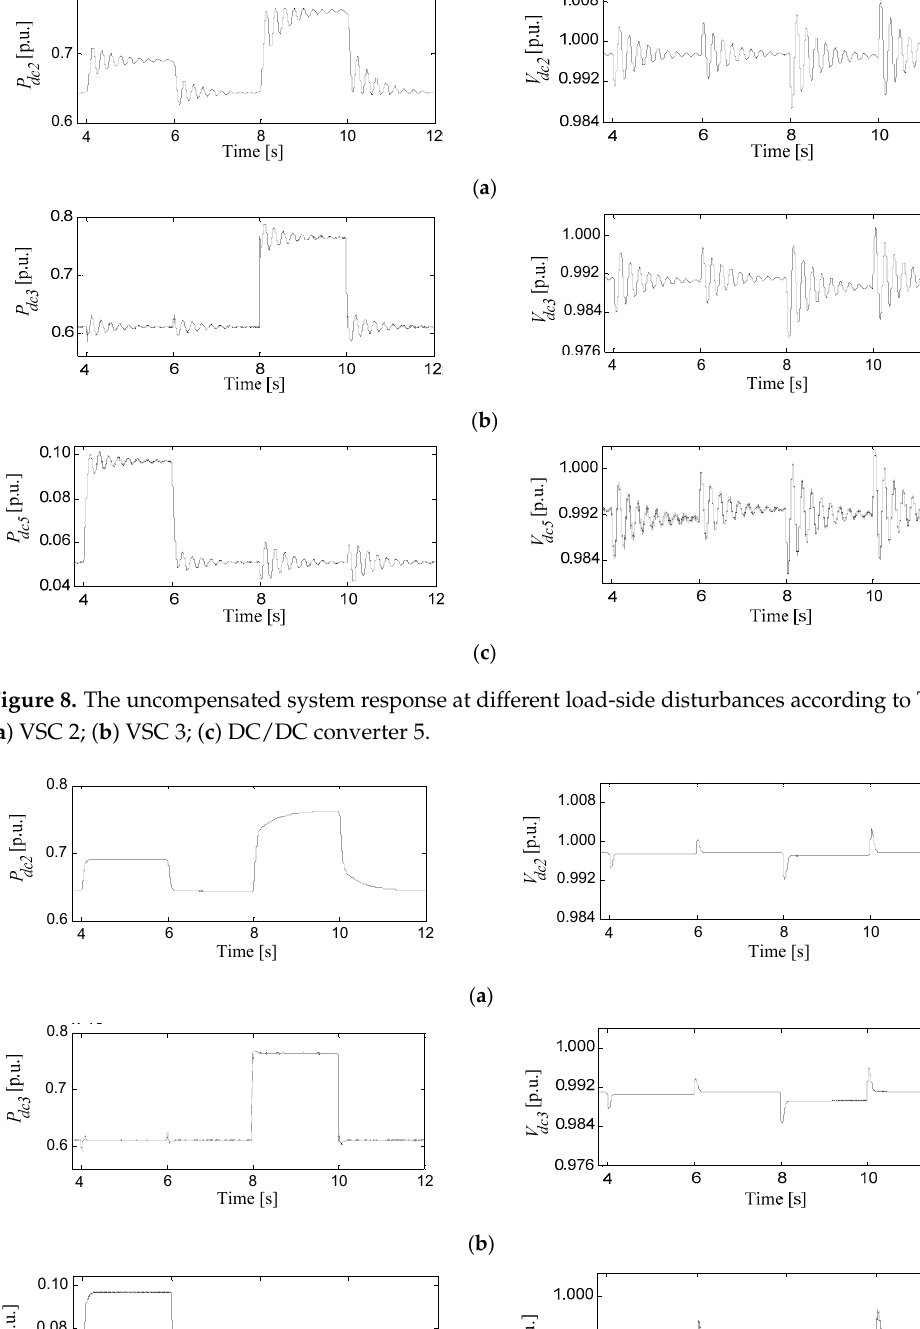
Table 6. Loading Sequence in the MTDC Network.